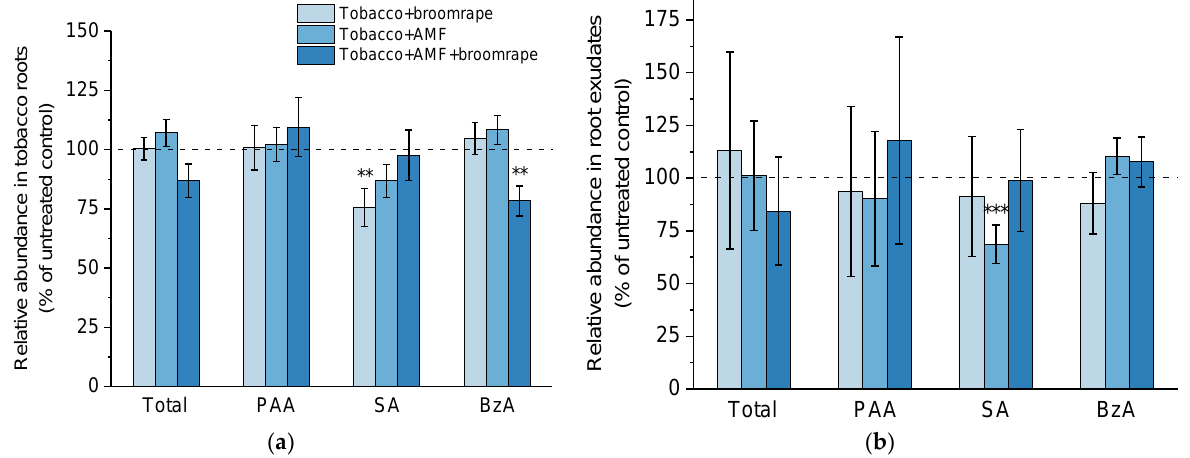
Figure 4. Levels of phenylacetic acid (PAA), salicylic acid (SA), and benzoic acid (BzA) in roots ( a ) and exudates ( b ) of tobacco plants upon broomrape infestation and/or colonization with arbuscular mycorrhizal fungi (AMF). Values are relative to the non-infested and non-inoculated control (dashed line), and are means of four biological repeats (i.e., independent experiments), with three plants per variant analyzed within each repeat. Error bars indicate standard error of the mean (SE). *** p < 0.001 and ** p < 0.01 (Student’s t